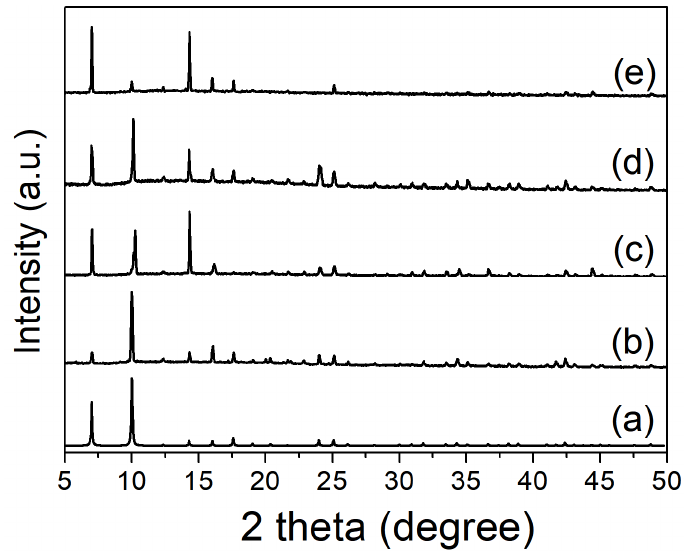
Figure 2. PXRD patterns of ZnBPD-4F4TS : (a) A simulated one obtained from single crystal data, (b) as-synthesized one, (c) after exposed to air for 21 days, (d) activated sample after acetone exchange and thermal treatment at 100 °C and vacuum, (e) after soaking in boiling water for 30 h.